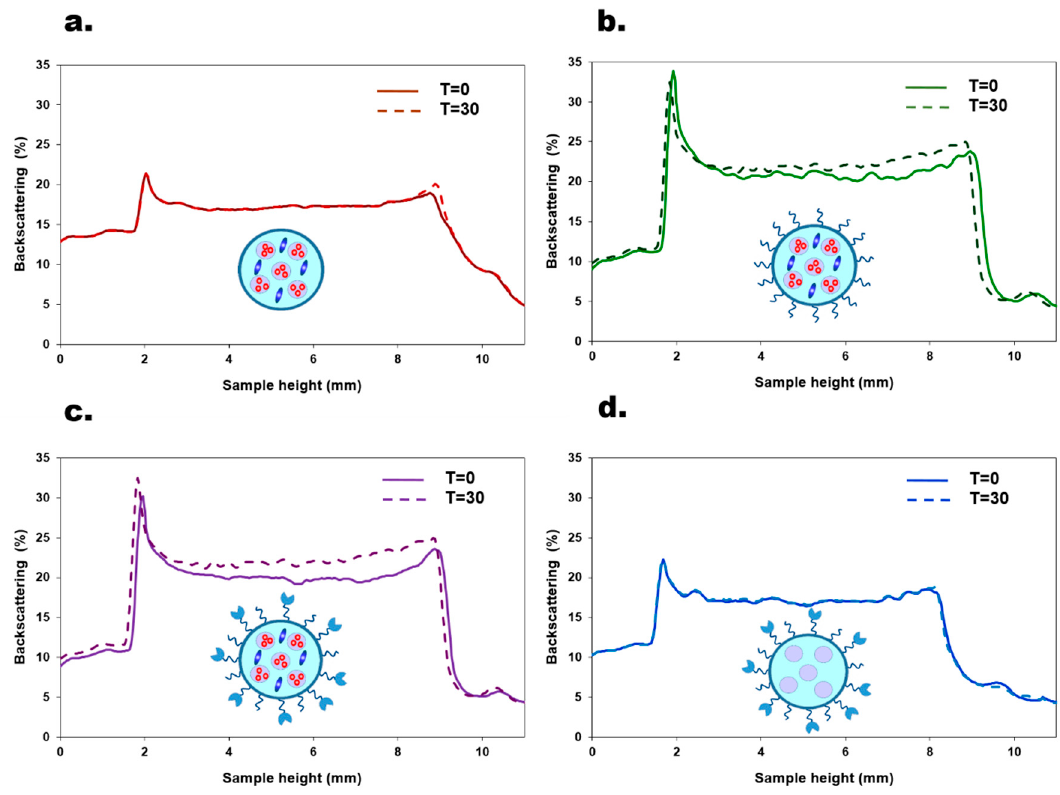
Figure 3. Backscattering profiles of the various PLGA NCs co-loaded with VP and CisPt ( a – c ) (V1–V3) and an empty ( d ) (V6) FA-PLGA nanosystem as a function of sample height (mm) analyzed over 30 days ( T = 30) of the NCs’ storage. Solid lines represent measurement at 0 day ( T = 0, freshly prepared NCs), while dashed lines indicate data obtained after 30 days of storage. See descriptions of the systems in Table 1.